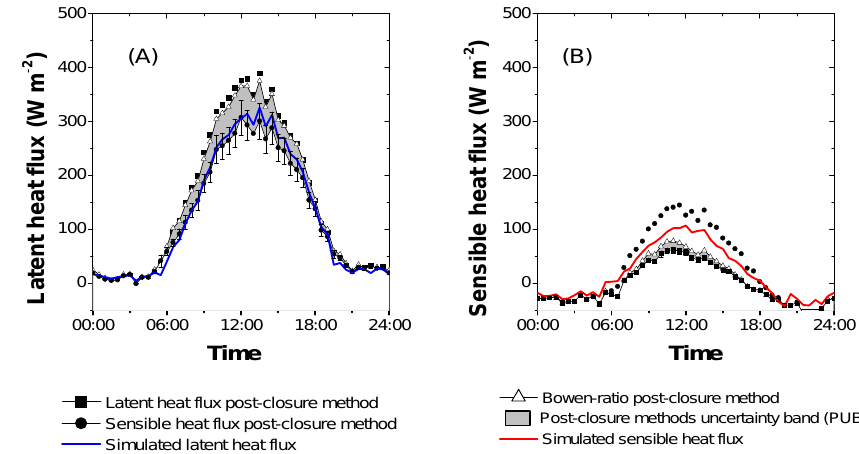
Figure 1. Illustration of the post-closure methods uncertainty band (PUB) to consider the systematic error in eddy covariance (EC) flux data. The grey band shows the PUB computed as the difference between Bowen ratio-adjusted and non-adjusted fluxes. The closed squares in (a) indicate the latent heat (LE) post-closed fluxes, and the close circles in (b) show the sensible heat ( H ) post-closed data. The error bars indicate the random measurement error. In some cases, the error bars are smaller than the size of the symbol and therefore not visible. Note: in the case of latent heat flux, raw data and H post-closed data are identical. In the case of sensible heat flux, LE post-closed data and raw data are identical. Table 1. Overview of possible bound combinations to construct the post-closure methods uncertainty band (PUB). The upper and lower bound of the band are constructed from the difference between raw fluxes and fluxes adjusted by one of the three post-closure methods (Bowen ratio ( B ), sensible heat ( H ), and latent heat (LE) method). Bound Lower bound = PUB width >0 Useful combination